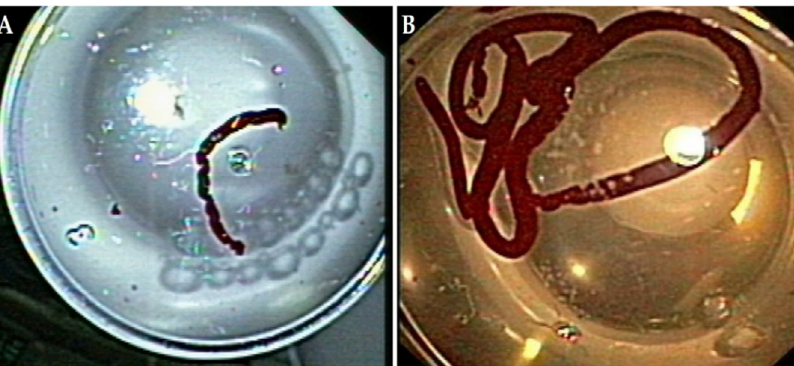
Figure 1. Cytology specimen after a puncture of a mass in the pancreatic body. The specimen was considered ( A ) inadequate and ( B ) adequate by the examiner. Photos are from author’s personal archive.